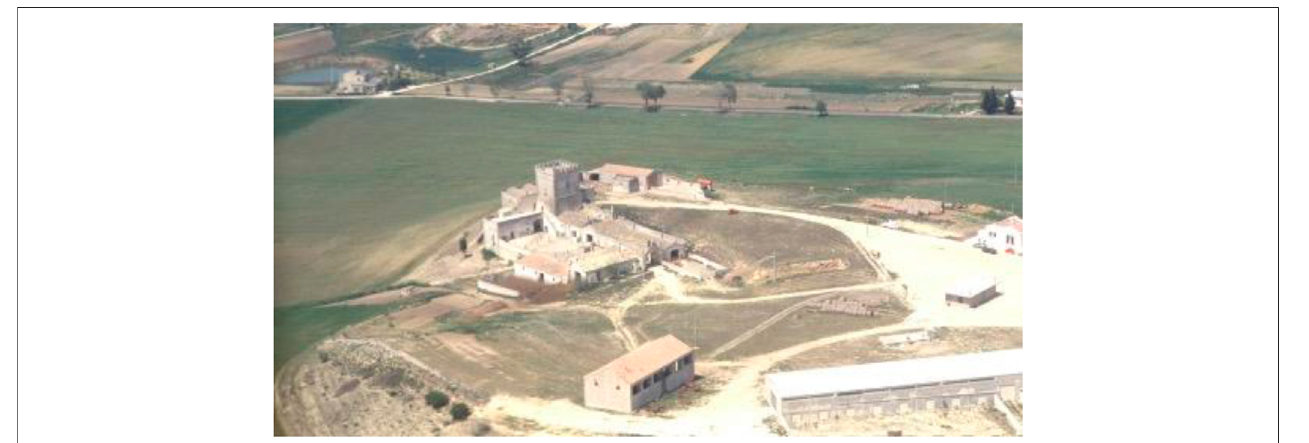
FIGURE 9 | Aerial view of forti fi ed ancient Masseria “ Torre Spagnola ” (southern Italy, Basilicata region).